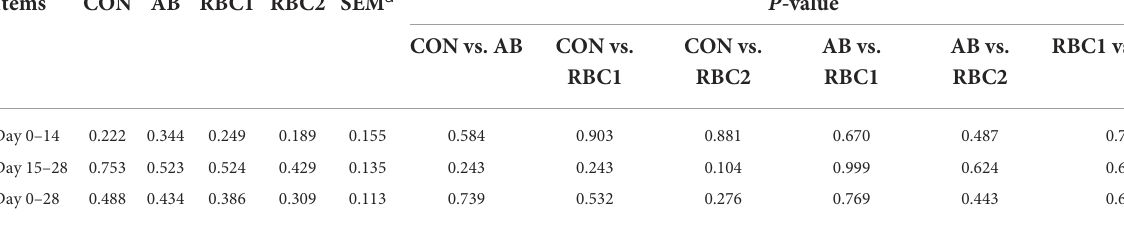
TABLE 3 Effect of dietary RBC and AB supplementation on the diarrhea score of weaning piglets (%).